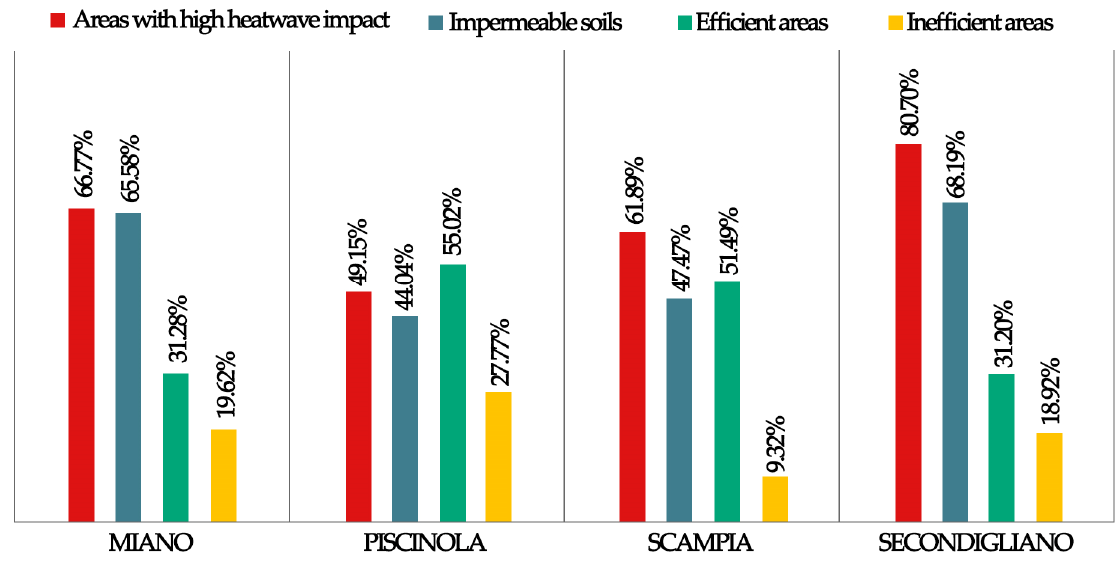
Figure 3. Histogram showing the percentages of areas with high heatwave impact levels, and the percentages of impervious soils and of ecologically efficient and inefficient green areas.